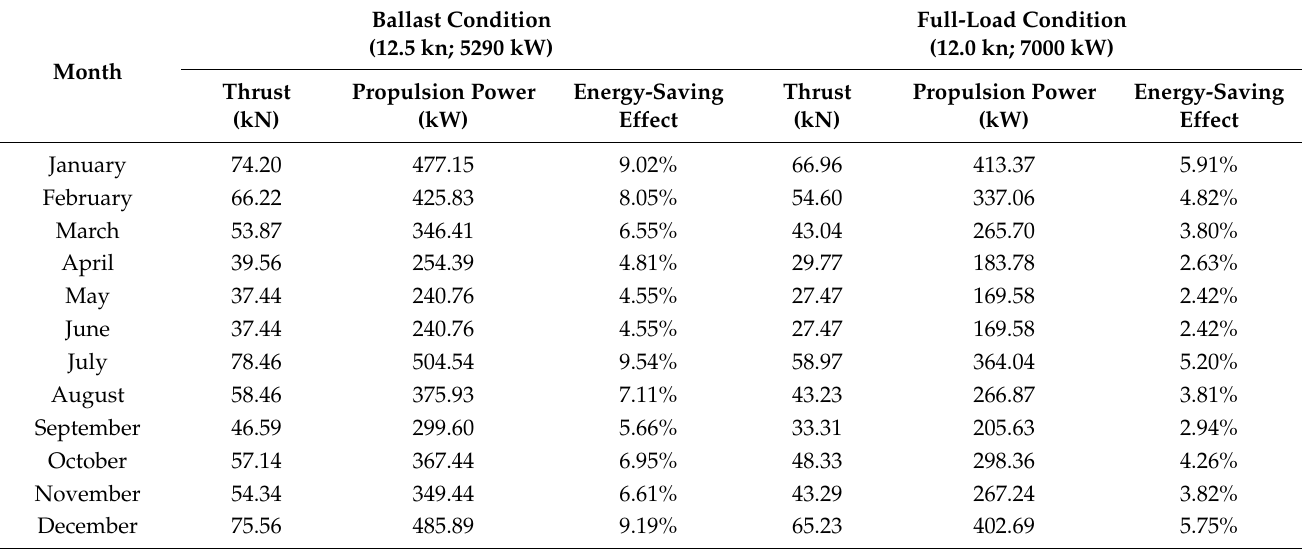
Table 7. Energy-saving effect of wing sails on target